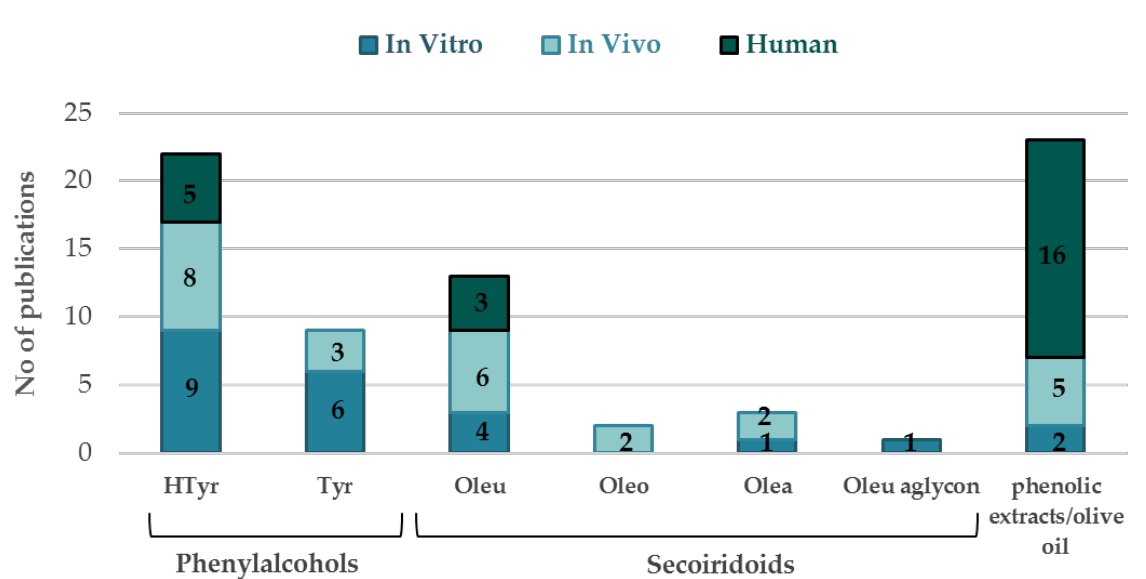
Figure 2. Bar chart of the number of research articles for the ADMET properties of olive-characteristic compounds categorized in in vitro, animal and human studies. In each bar, the respective number of publications is illustrated. HTyr: hydroxytyrosol, Tyr: tyrosol, Oleu: oleuropein, Oleo: oleocanthal, Olea: oleacein, Oleu aglycone: oleuropein aglycone, EOO: enriched olive oil. Time span 2000–2020.